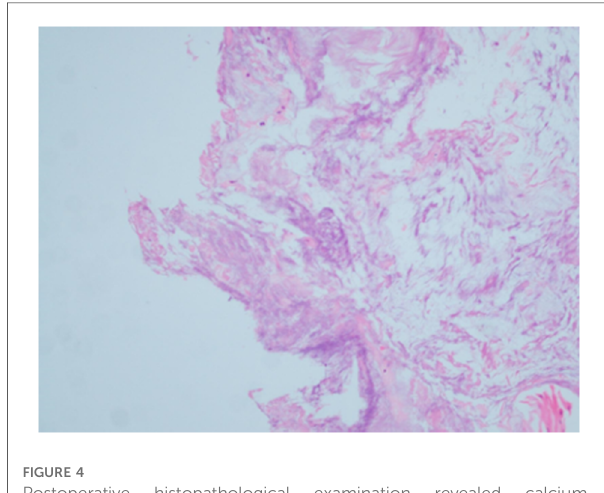
FIGURE 4 Postoperative histopathological examination revealed calcium hydroxyapatite deposition with necrosis of surrounding tissue.